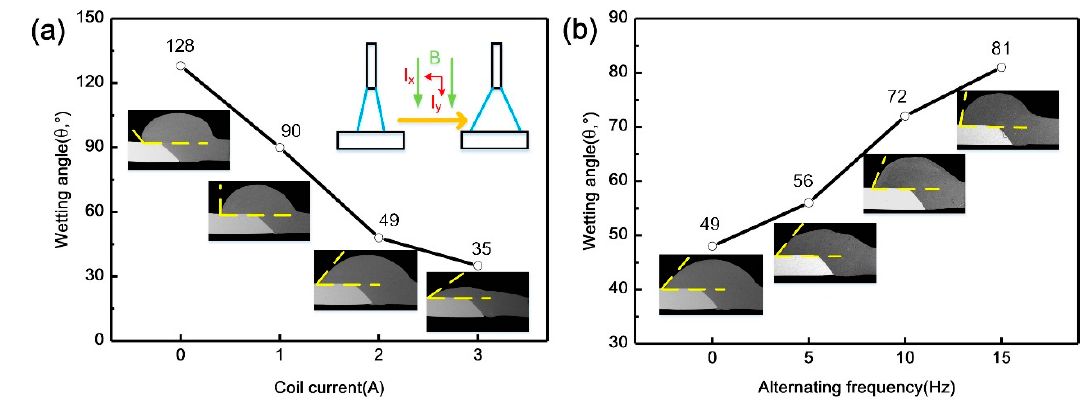
Figure 3. Wetting angle and cross sections of aluminum on steel surface at different magnetic field parameters: ( a ) Coil current; ( b ) alternating frequency.